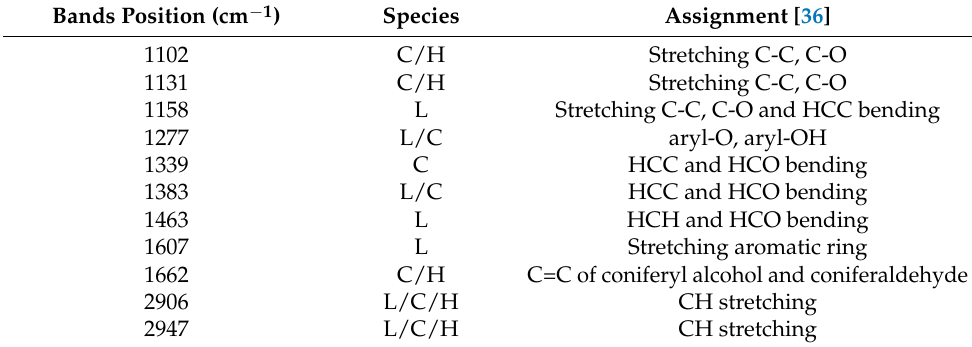
Table 3. Raman bands assignment of BIO01.